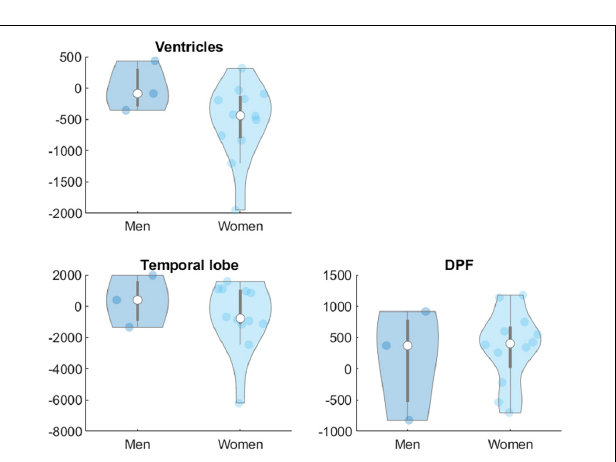
FIGURE 3 | Sex difference in changes in brain volumes (Level 2) in mm 3 for group COMB. DPF, dorsolateral prefrontal